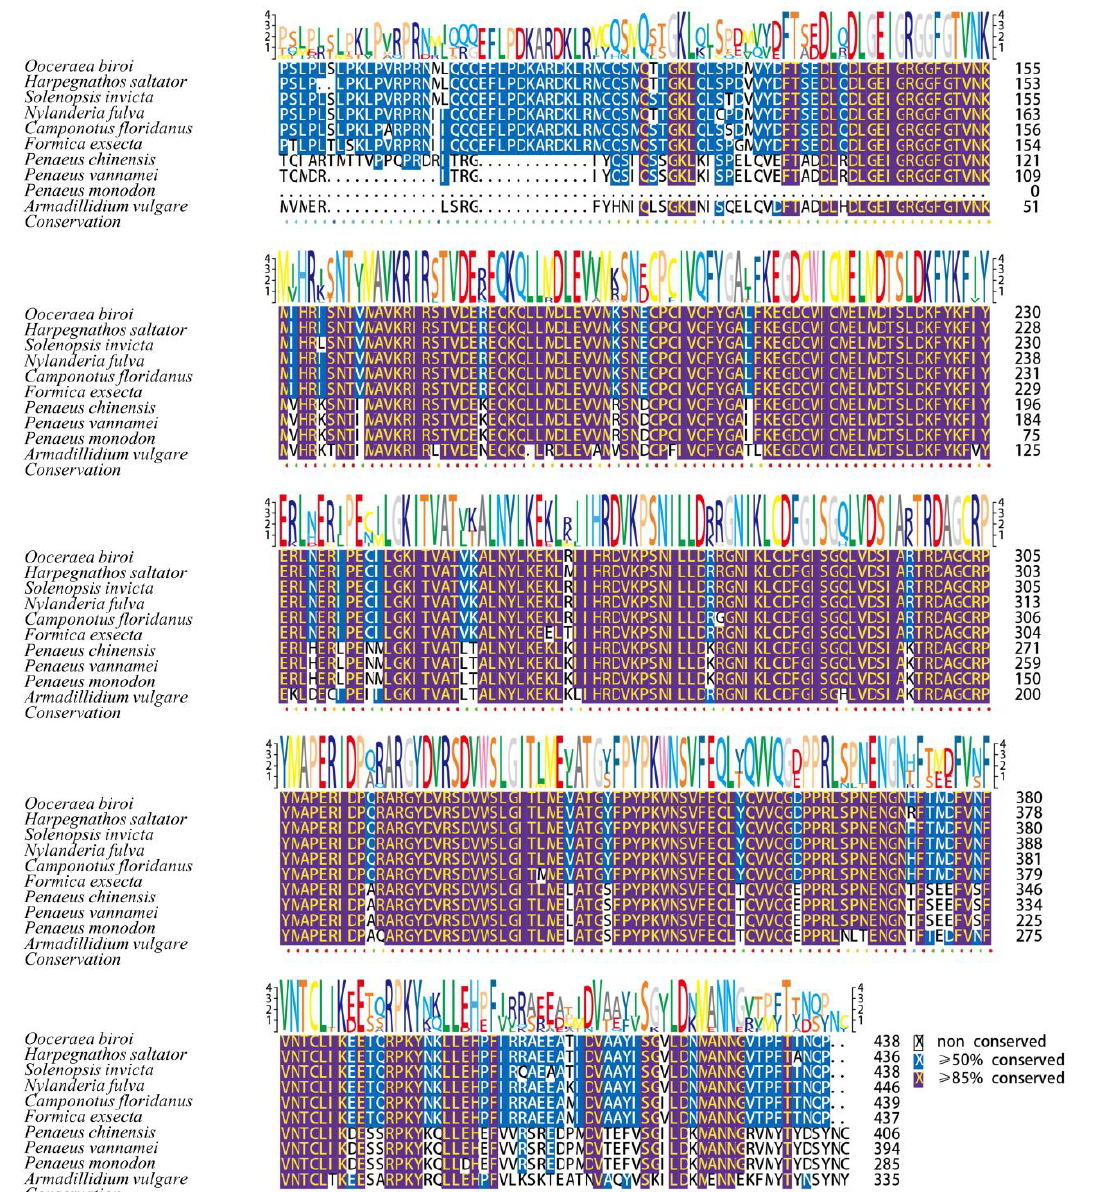
Figure 2. Multiple alignment of the amino acid sequences of MKK4 in P. monodon and other species. Thymosins sequence numbers used in multiple alignment included L. vanname (AQY45917.1), F. chinensis (AIY23114.1), A. vulgare (RXG53605.1), O. biroi (XP_011345314.1), H. saltator (XP_011144111.1), S. invicta (XP_011160881.1), N. fulva (XP_029170034.1), C. floridanus (XP_011252612.1), and F. exsecta (XP_029664029).